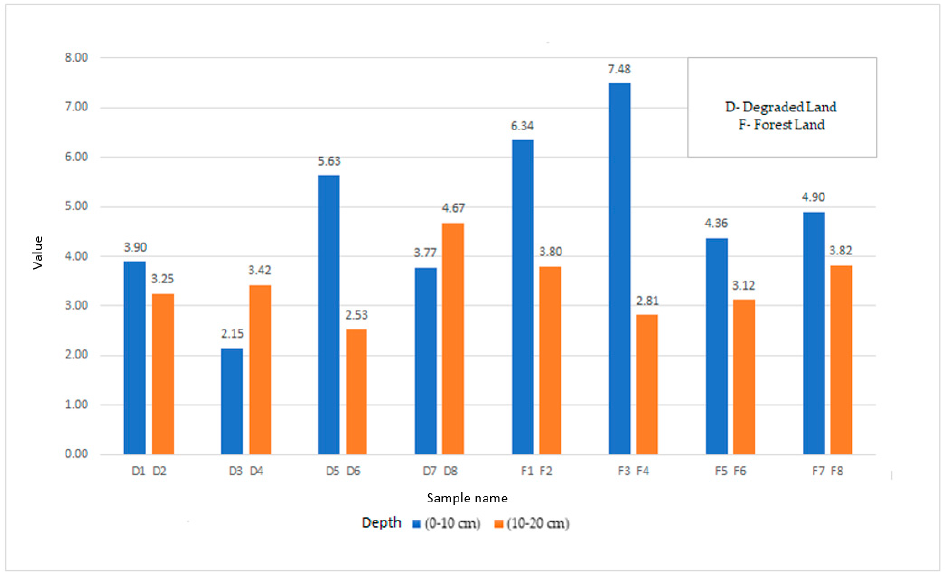
Figure 6. Variation of organic carbon depending on the depth and type of land use.